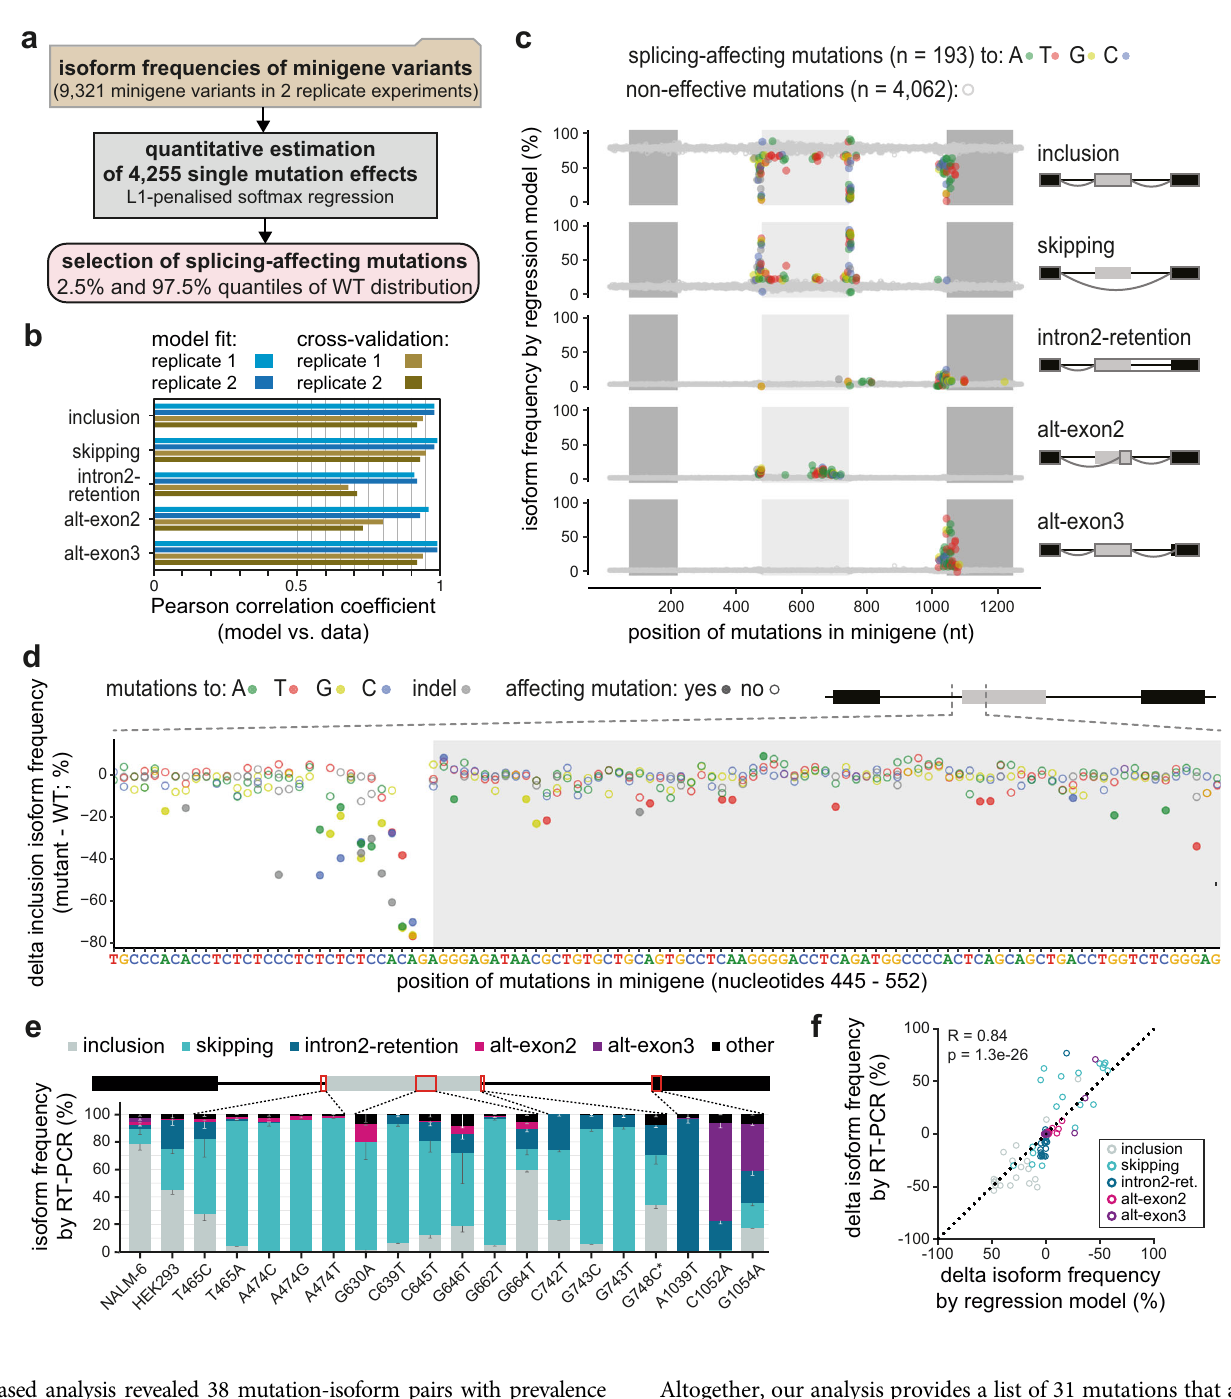
based analysis revealed 38 mutation-isoform pairs with prevalence scores > 0.25 which could explain the genesis of 36 cryptic isoforms based on 31 point mutations (Supplementary Fig. 6a, Supplementary Data 2). The remaining 60 cryptic isoforms do not show a speci fi c association, implying that they can either be generated by multiple redundant mutations, or that our screen lacks suf fi cient coverage to support a reliable association. To directly test the predicted associations, we introduced fi ve mutations with a speci fi c association to a cryptic isoform in our minigene reporter (C535G, chr16: 28932405, prevalence score = 0.18; C806A, chr16:28932676, 0.68; A827T, chr16:28932697, 0.93; C864G, chr16:28932875, 1; G1005A, chr16:28932734, 0.89). Semiquantitative RT-PCR con fi rmed that all fi ve tested mutations lead to the appearance of the associated cryptic isoform (Fig. 4c,